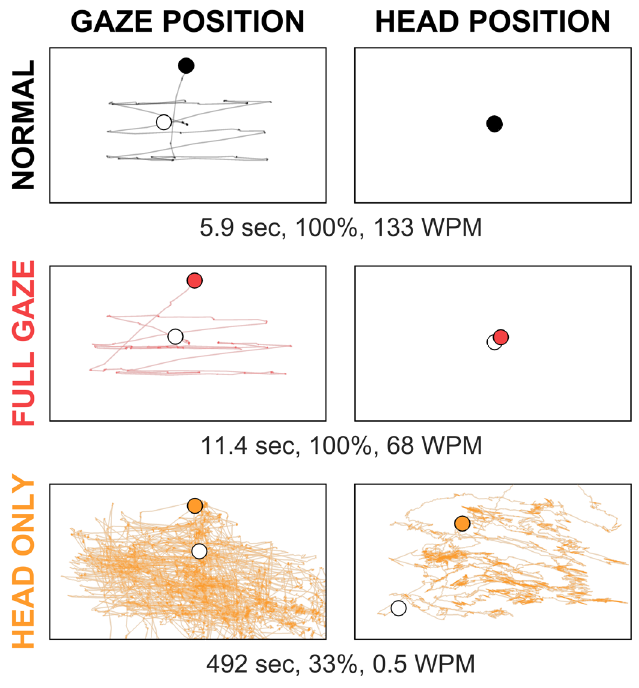
Figure 4. Example gaze and head traces from one subject. Gaze (left column) and head (right column) position traces are shown for one of the most overall-capable subjects reading text at 1.4 logMAR (the largest size) under the three viewing conditions, Normal (top row), Full Gaze (middle row), and Head Only (bottom row). For each trace, the start is shown by an unfilled circle, and the end by a filled circle. Trial length, reading accuracy, and reading speed are shown underneath each pair of plots: the first two trials (top two rows) took some few seconds to complete while the third trial (bottom row) took over 8 min; for Head Only, the values are substantially better than the population means, but a similar dichotomy in trial completion time was typical across the population. Eye movements during the Normal and Full Gaze conditions here follow a typical scan path for reading the three lines in the MNREAD sentences; head position is nearly motionless, also typical, without having instructed the subject to hold their head still. Eye movements in the Head Only condition reflect stereotypical looping center-out-and-back movements, while head position reflects attempts to scan the scene. This looping behavior is triggered by eye movements to foveate a portion of text the subject wishes to view, followed by